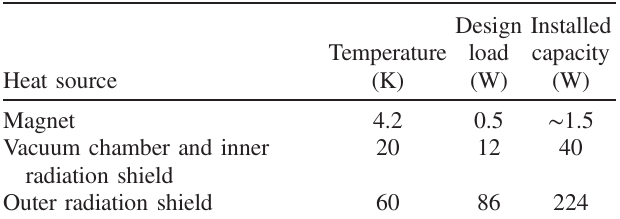
TABLE IV. Design heat loads and installed cooling capacity.